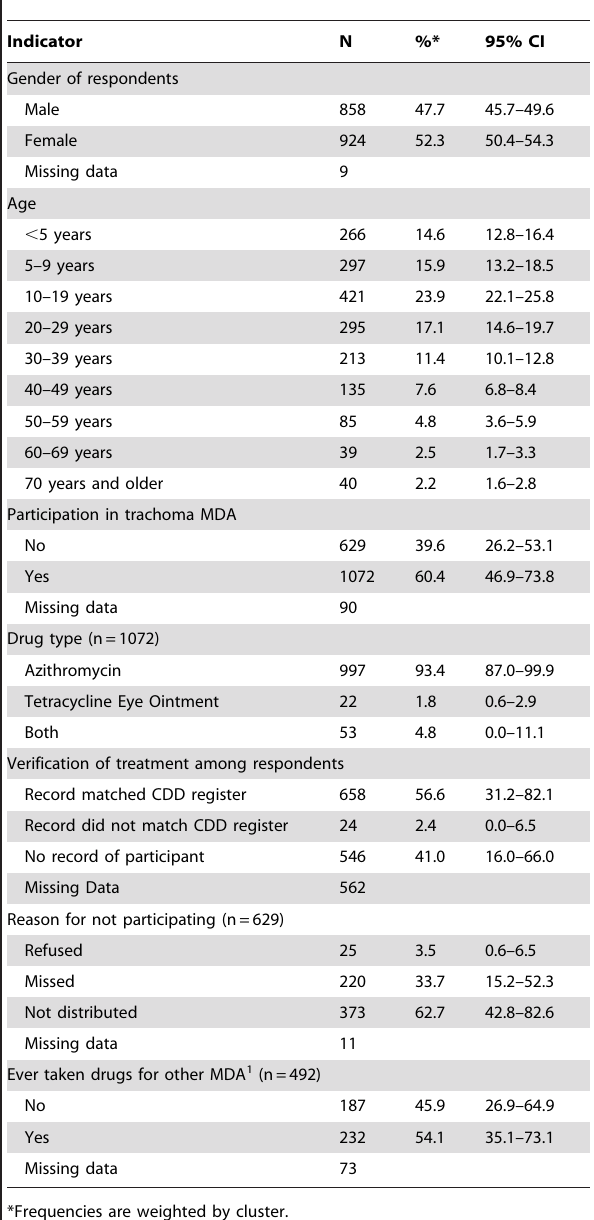
Table 2. Individual Participation in trachoma MDA (N=